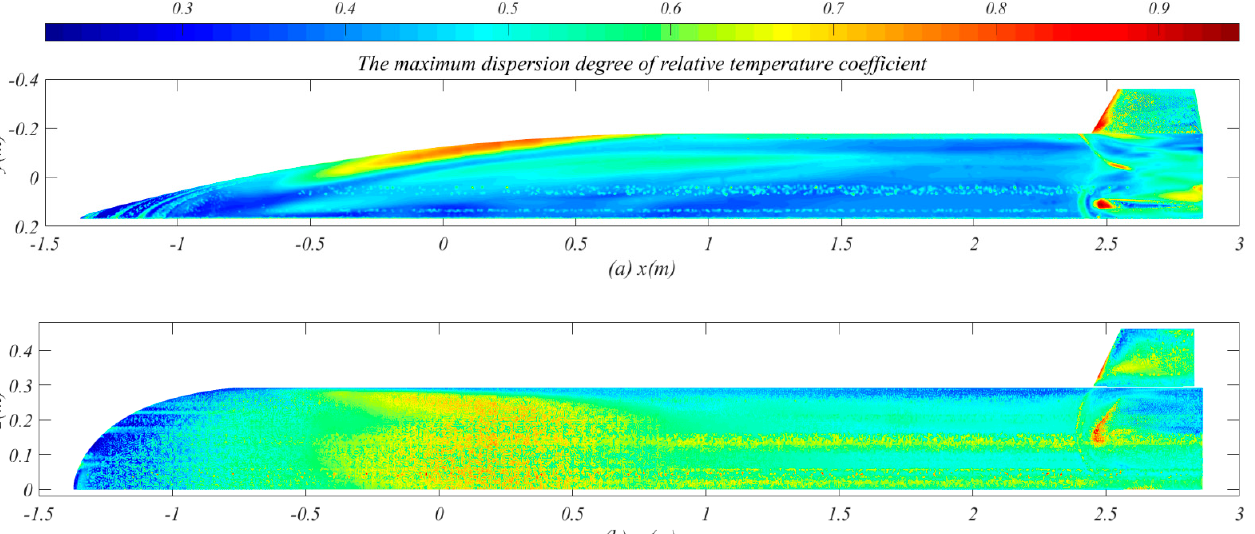
Figure 10. The maximum differential value of relative temperature coefficient with different angles of attack: ( a ) the side view of aircraft; ( b ) the top view of aircraft.